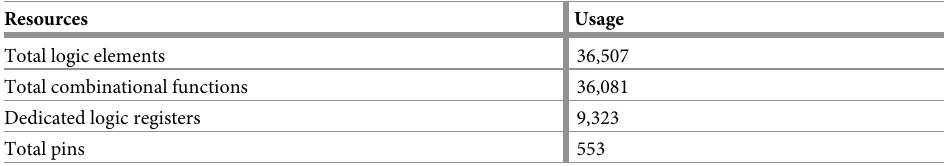
Table 1. Used resources in FPGA